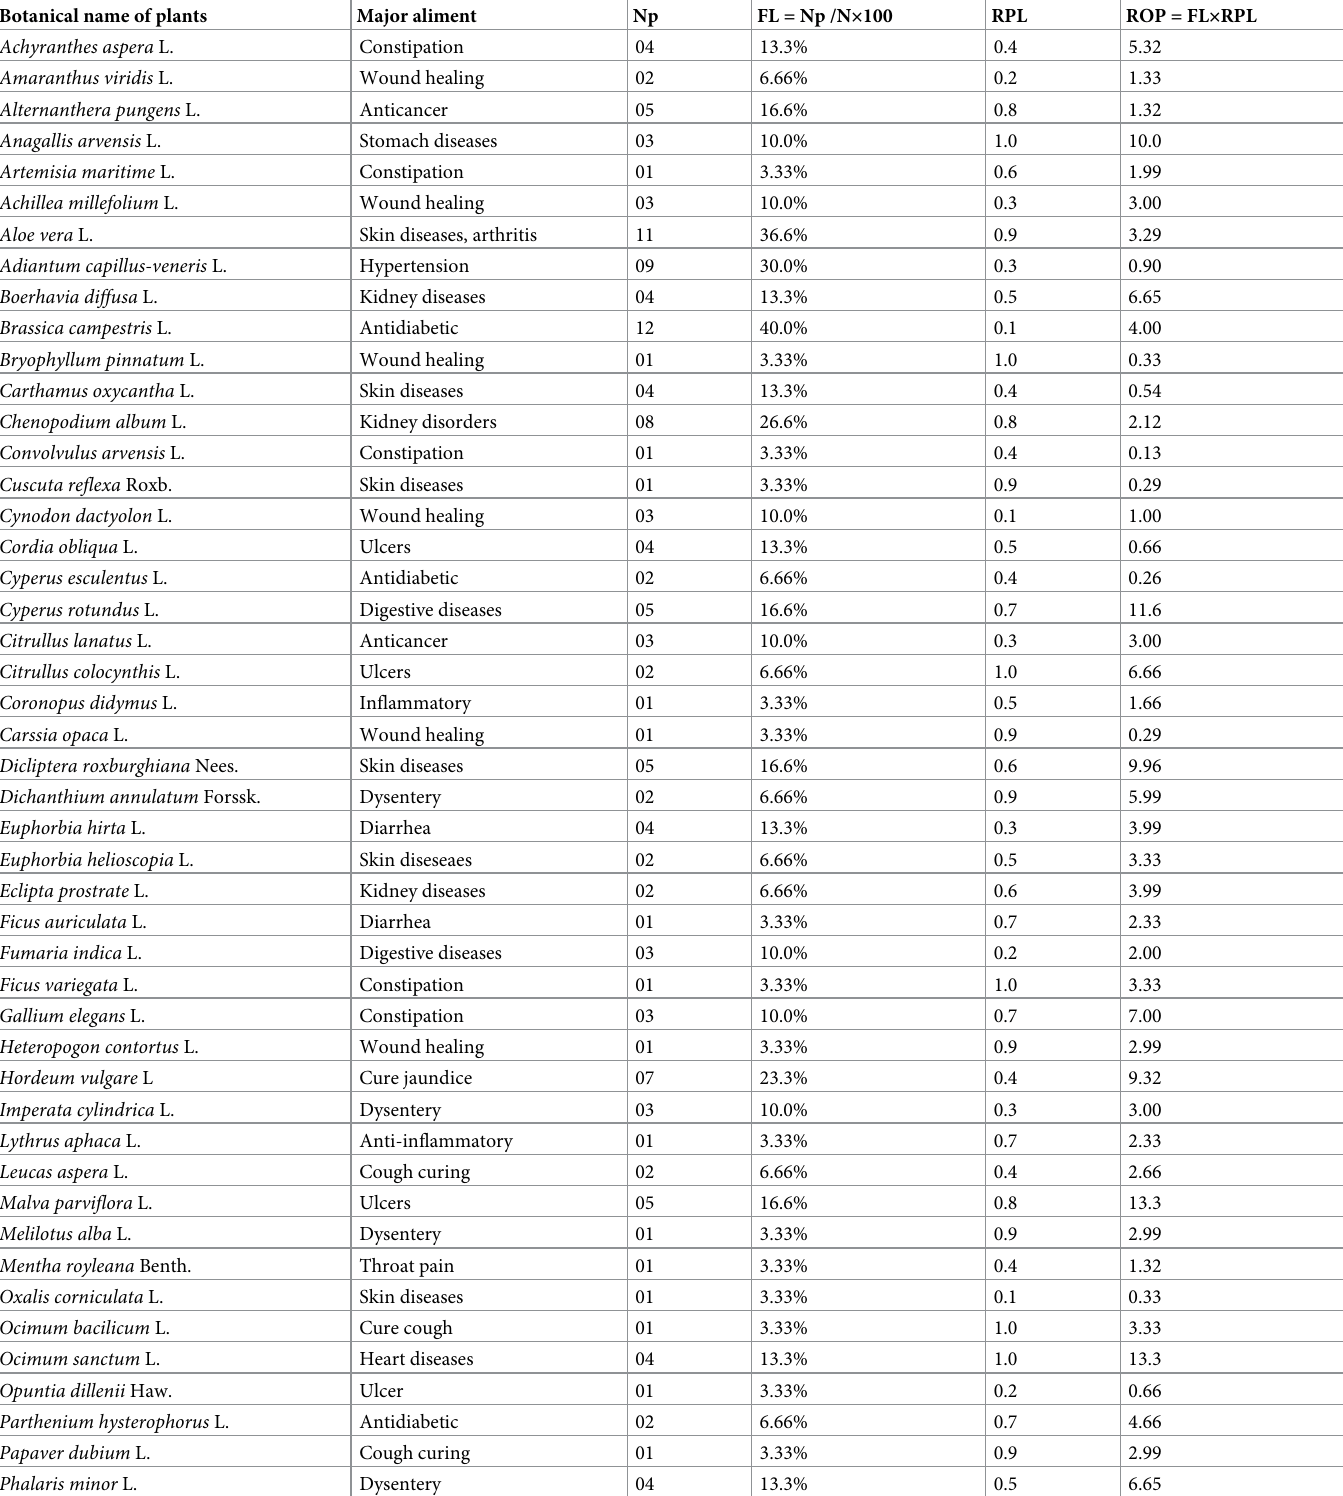
Table 7. Fidelity Level (FL), RPL and ROP of some dominant herb species used to treat some diseases in study area (total number of informants = 35). Botanical name of